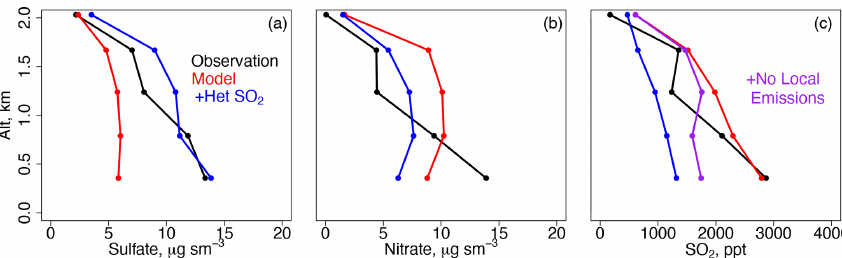
Figure 13. The same as Fig. 3 but for the Transport/Haze period only for (a) sulfate, (b) nitrate, and (c) SO 2 . The sensitivity studies are described in Sect.